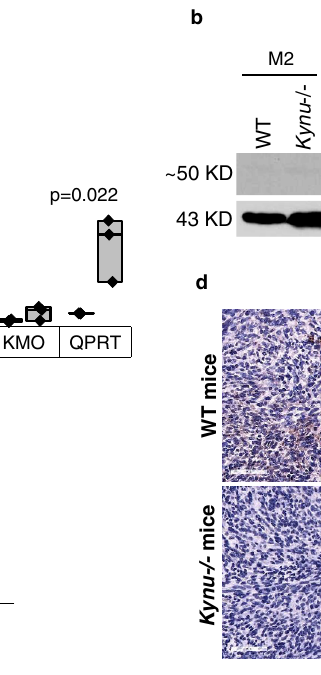
Fig.7|TargetingthedownstreammetabolismoftryptophaninGBMusingthe Kynu -/- model. a Macrophages obtained from C57BL/6 mice were polarized towards the M2 phenotype ±QA (20 µ M), and RNA was isolated and evaluated for indicated genes using real-time PCR. Bar graph represent mean±SD ( n =3 biolo- gically independent samples/group). b Macrophages obtained from C57BL/6NJ Kynu -/-and WT mice were polarized towards the M1 or M2 phenotype in ±QA, and indicatedproteinswere evaluatedbywesternblot,whichisrepresentativeofthree